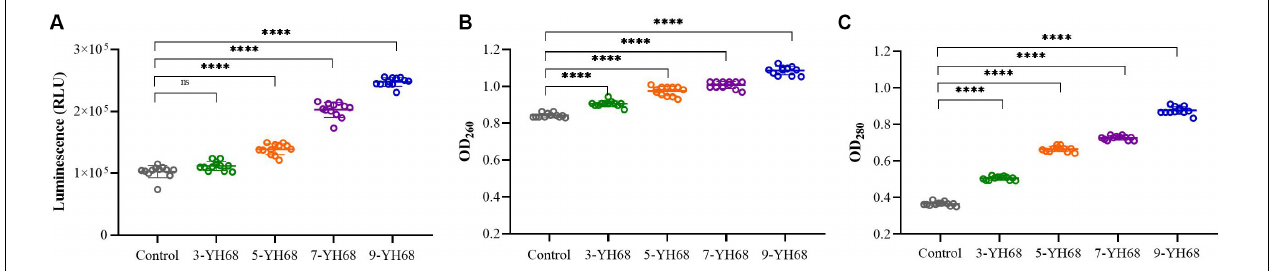
FIGURE 3 | Effects of YH68-CFCS at different doses on C. difficile cells. (A) Luminescence values represent the extracellular ATP level, (B) OD 260 values represent the extracellular nucleic acid substances level, (C) OD 280 values represent the extracellular protein substances level. (Sterile water is used as a control, ns, not significant, and ∗∗∗∗ P < 0.0001; Dunnett’s multiple comparisons